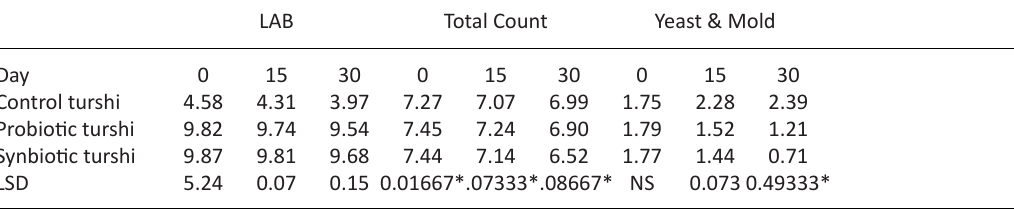
Table 1. microbiological content of Control, Probiotic and Synbiotic turshi samples LAB Total Count Yeast &